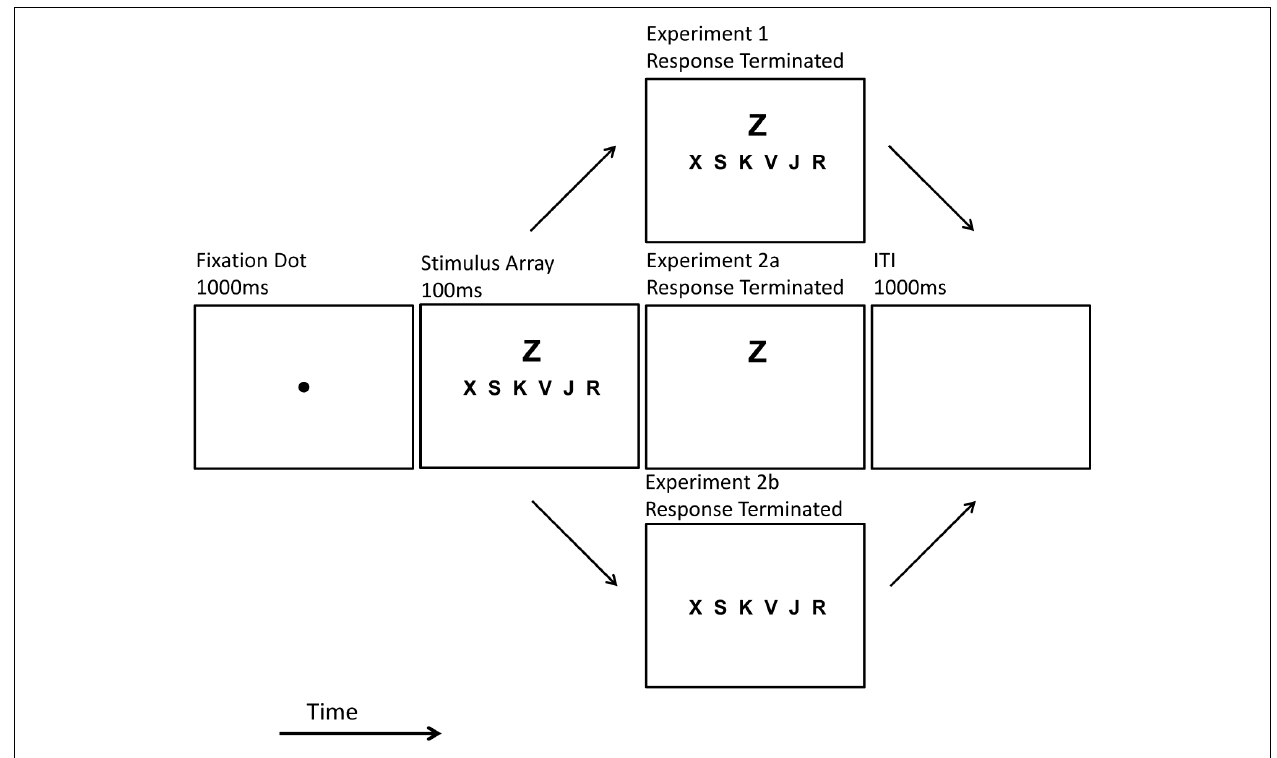
FIGURE 2 |Trial schematic. Example of high p- Load, response terminated displays as presented in Experiments 1 and 2.